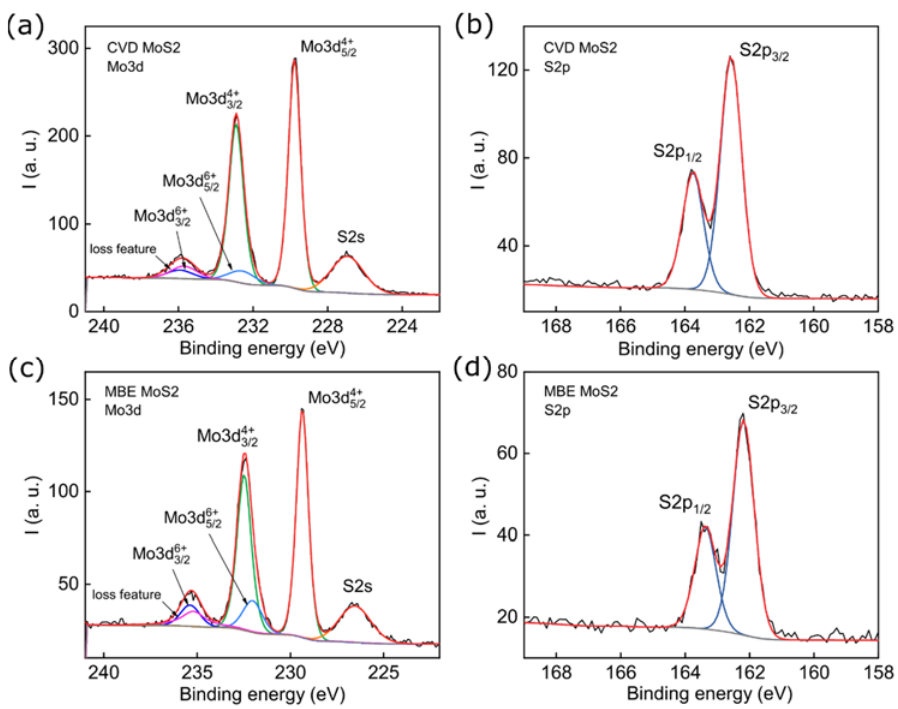
Figure 3. XPS characterization of CVD ( a , b ) and epitaxially ( c , d ) grown MoS 2 monolayers on sapphire substrates. Decomposition of Mo3d (left) and S2p (right) core level signals into their constituents. The S2p spectra were described by a doublet with the S2p5/2 line position at 162.6 eV and a spin-orbit splitting of 1.2 eV for the CVD MoS 2 sample and at 162.2 eV and the same spin-orbit splitting for the MBE MoS 2